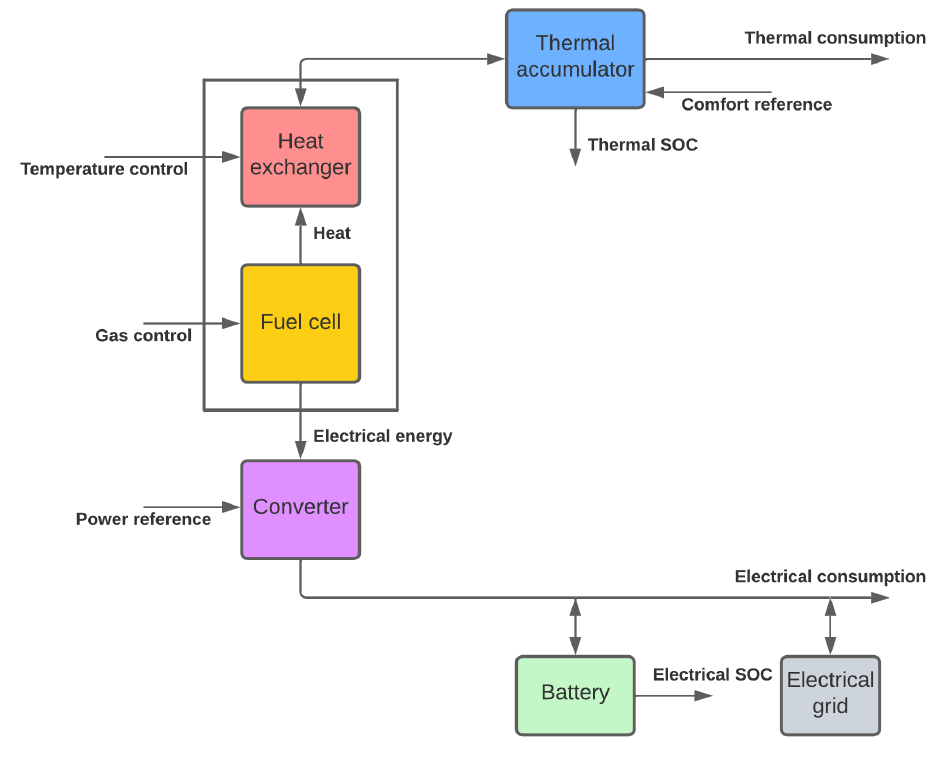
Figure 7. CHP plant and its controlled